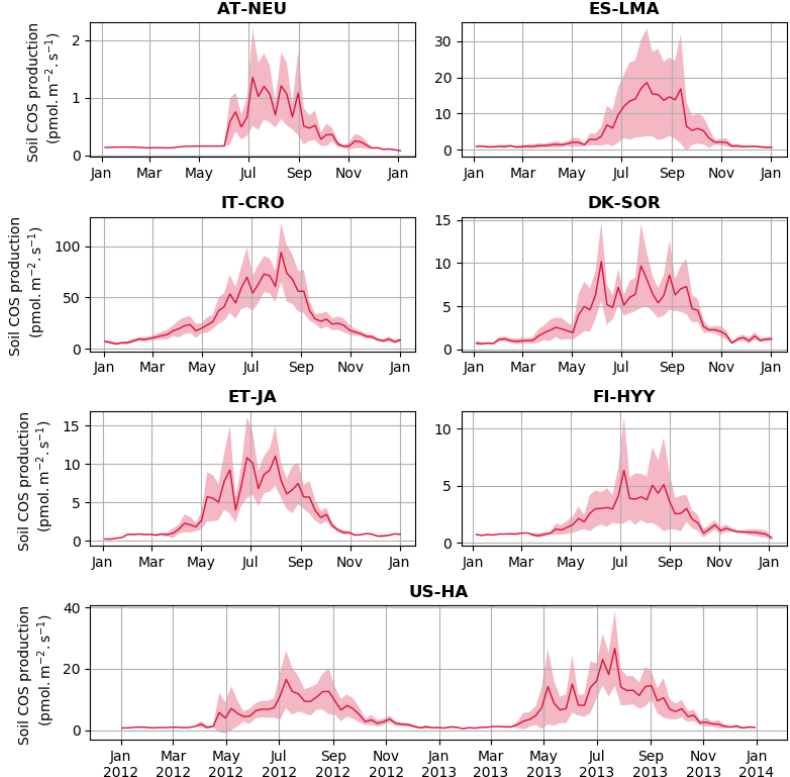
Figure C1. Seasonal cycles of soil COS production with weekly average production at AT-NEU, ES-LMA, IT-CRO, DK-SOR, ET-JA, FI- HYY, and US-HA. The shaded areas above and below the modelled curve represent the standard deviation over a week. Soil COS production was computed with a variable atmospheric COS concentration.